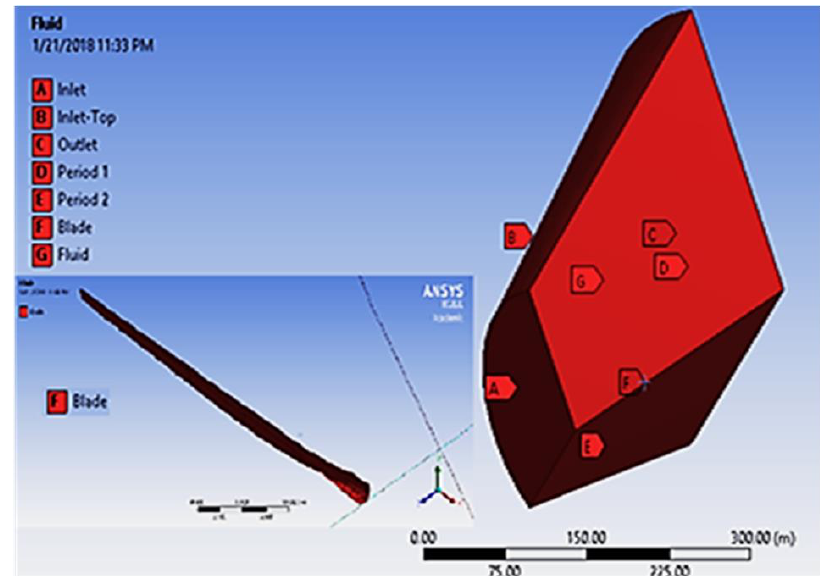
Figure 11. Final fluid domain with various faces of geometry.